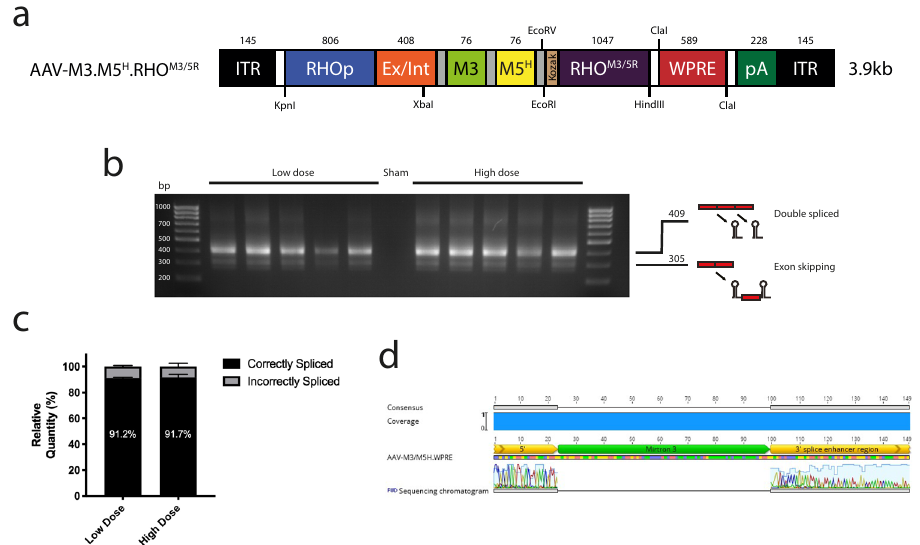
Fig. 4 Arti fi cial mirtrons delivered by a recombinant AAV vector are ef fi ciently spliced from transgenic pre-mRNA in vivo. a Genome map of AAV-M3. M5 H .RHO M3/5R . Size in bp is indicated above each element and locations of relevant restriction sites marked. Size of the entire genome is shown to the right. ITR: inverted terminal repeat, RHOp: human rhodopsin promoter, Ex/Int: Exon/intron/exon splice site from the CAG promoter, RHO M3/5R : codon- modi fi ed RHO coding sequence, WPRE: woodchuck hepatitis virus post-transcriptional regulatory element, pA: bovine poly-adenosine signal. b Arti fi cial mirtrons delivered by a recombinant AAV vector are ef fi ciently spliced from transgenic mRNA in vivo. DNA gel electrophoresis of amplicons generated using mirtron-spanning primers with template cDNA derived from AAV-M3.M5 H .RHO M3/5R -injected Nrl.GFP / + , Rho P23H/ + retinas ( n = 5). Schematics which illustrate the predicted origins of the bands detected, together with their size in bp, are shown to the right of the fi gure. The predominant band was of the size expected for transcripts from with which both mirtrons had been individually spliced. c Mean relative band density ± SEM for low (2 × 10 8 gc) and high dose (2 × 10 9 gc) samples ( n = 5). Displayed fi gures relate to the percentages of amplicons predicted to have arisen from correctly spliced transcripts. d Sanger sequencing of DNA extracted from the predominant (larger) band con fi rmed accurate splicing of the 76 bp M3 sequence. Sequencing of the M5 region, and of the smaller of the two bands, was unreliable and data are not